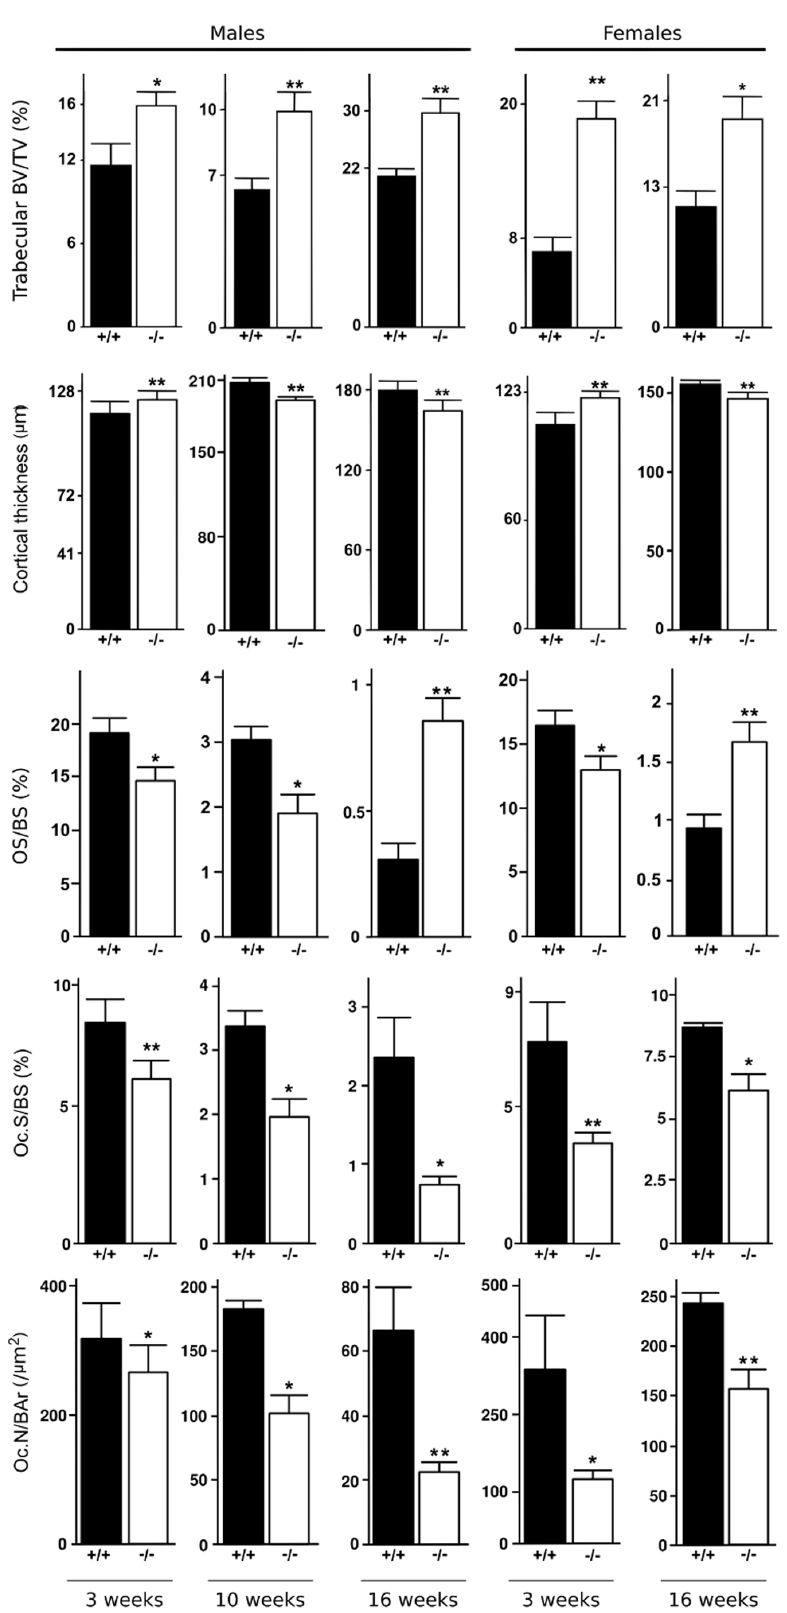
Figure 7. Static histomorphometric parameters and cellular activities in femur bones from 3, 10 and 16 week old BSP + / + ( + / + ) and BSP 2 / 2 ( 2 / 2 ) mice. Data are Mean 6 SEM of N=6 to 10 mice; *:p , 0.05, **:p , 0.001 vs BSP + / + , Mann-Whitney U Test. doi:10.1371/journal.pone.0095144.g007 PLOS ONE |